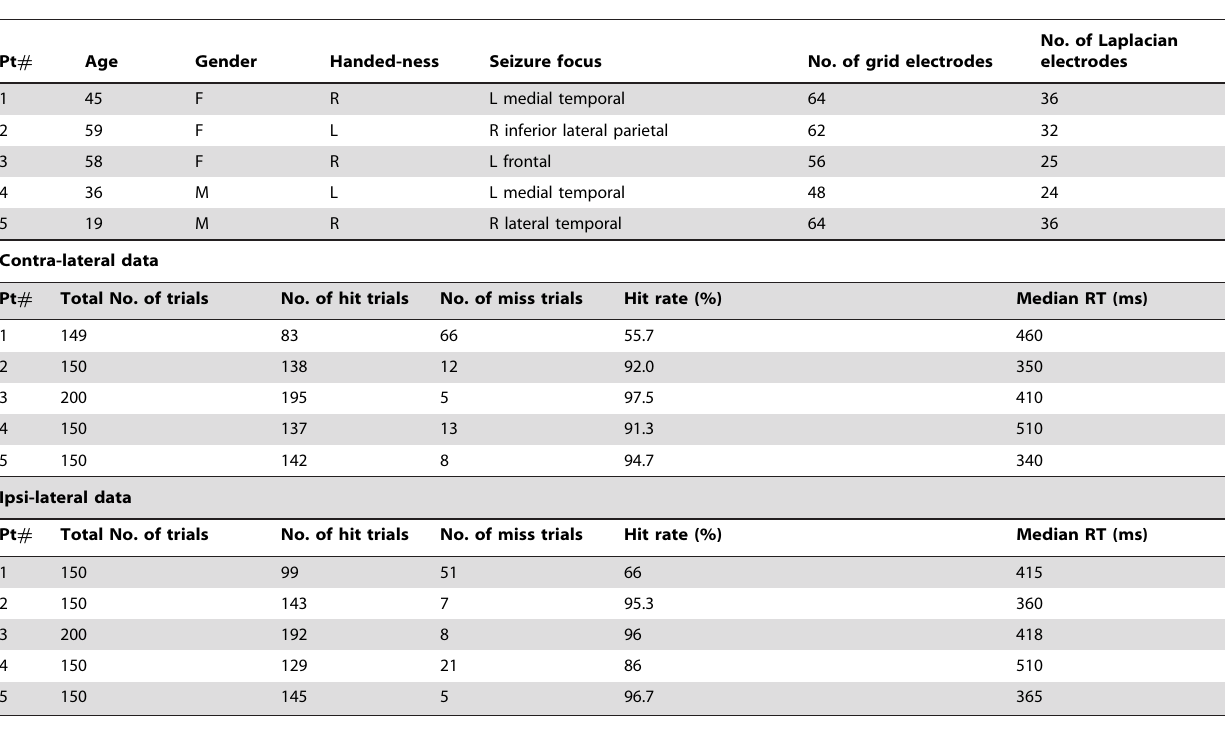
Table 1. Demographic, clinical and data collection information.